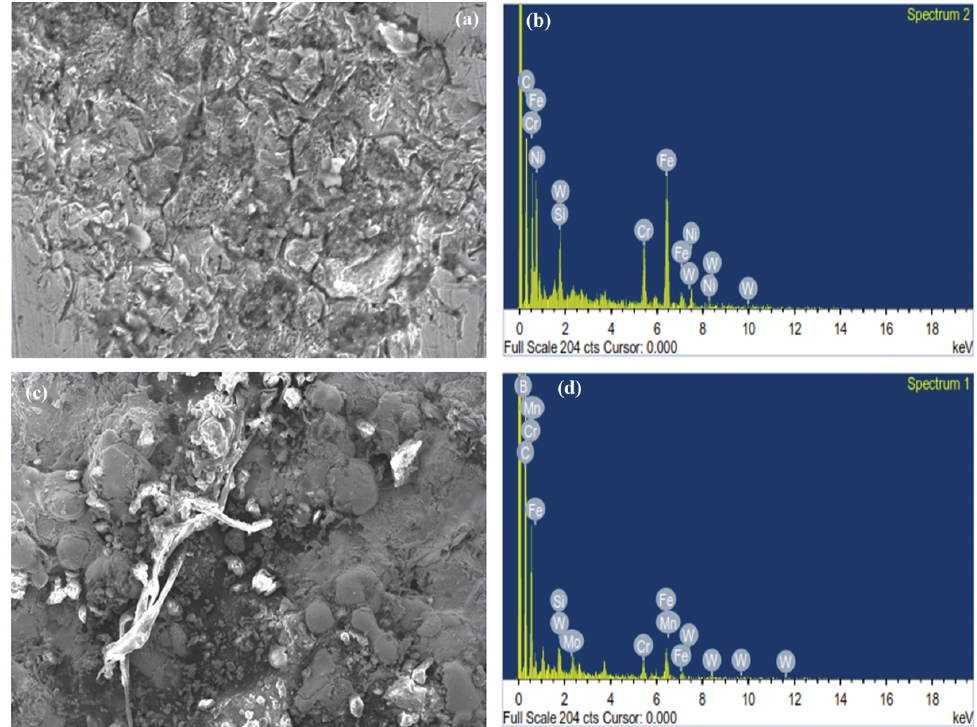
Figure 11: EDAX analysis of substrate and Fe-based amorphous coatings after potentiodynamic polarisation in 3.5 wt.% NaCl